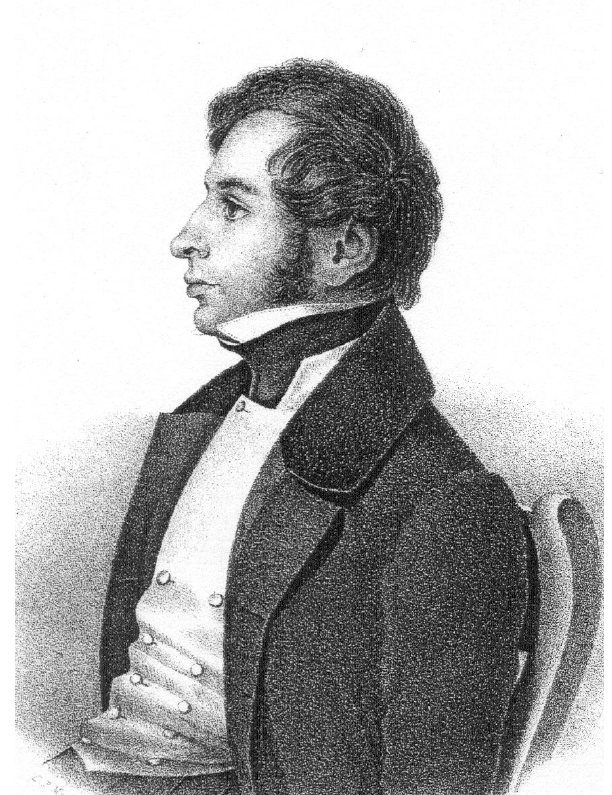
Figure 2. Johan Jakob Nervander (1805–1848), the first director of the Helsinki magnetic observatory, later the Finnish Meteorological Institute.